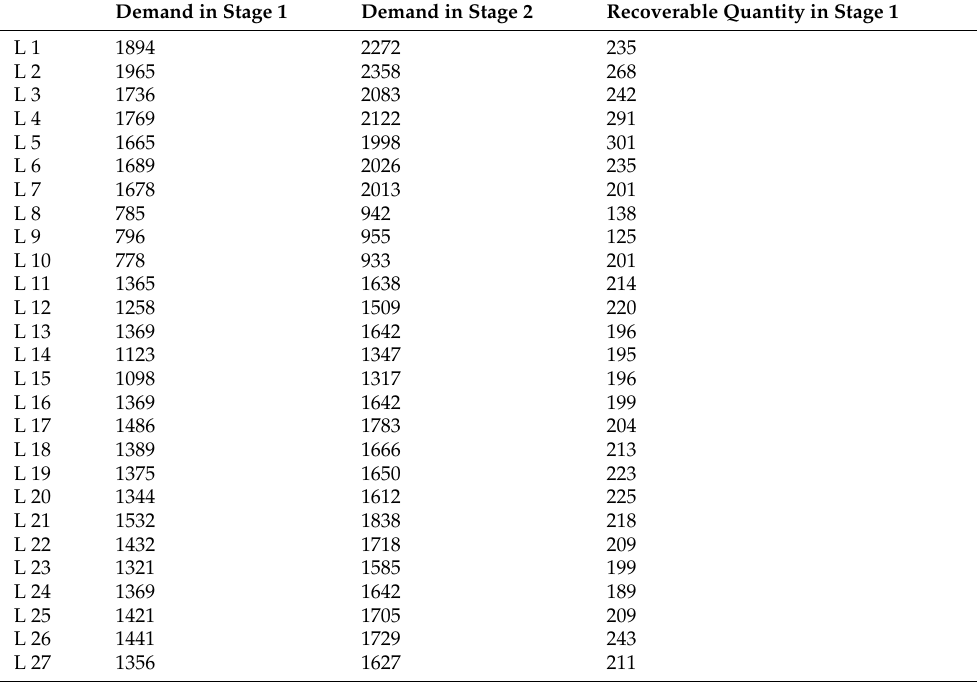
Table A13. Detailed data of demand and recovery of each consumption center